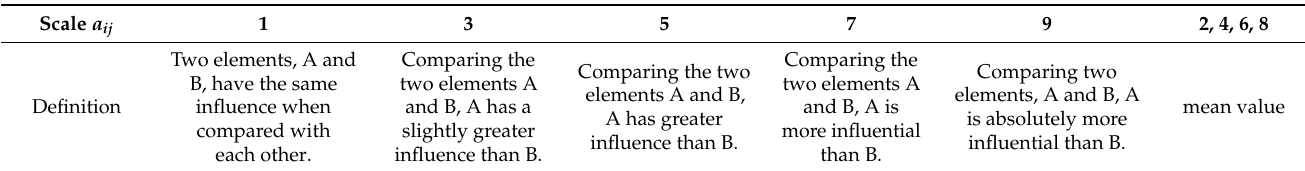
Table 5. The scale degree and meaning of the nine-grade scale method.